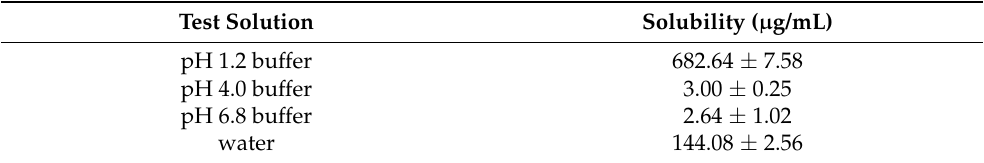
Table 1. The pH solubility of PZH in various pH. Data are presented as the means ± standard deviation ( n =